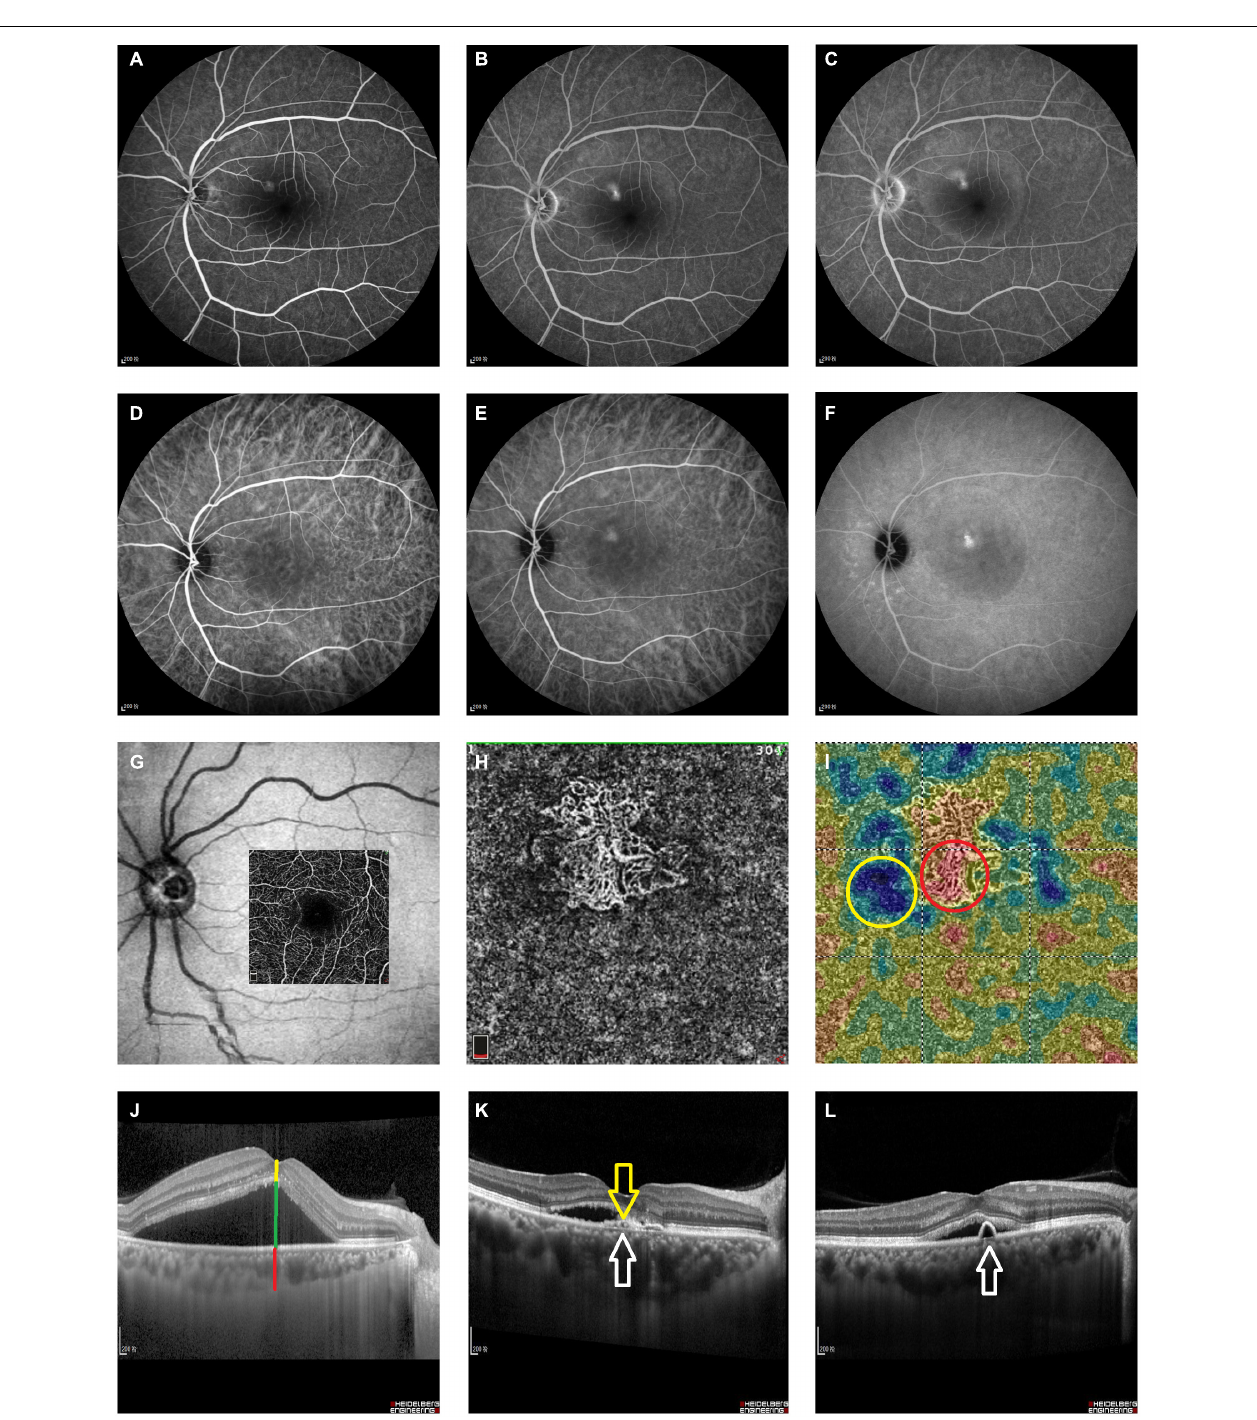
FIGURE 1 | Measurement features extracted from the imaging results. All imaging features used to predict recurrence. Please see Table 1 for detailed descriptions of all measurement features. (A–C) Early, middle and late phase FFA of the left eye of a 52-year-old patient with CSC. (D–F) Contemporaneous ICGA of the same patient. (G) The en face projection slab area of the 3*3 pattern on OCTA. (H) The observation of a superficial choroidal layer on OCTA confirmed the presence of BVN. (I) High- and low-reflection areas in the superficial choroidal layer were surrounded with red and yellow circles, respectively. (J) Horizontal B-scan OCT of a patient with CSC; manual measurements were labeled as follows: yellow line, RNEL; green line, SRF; and red line, ChT; (K) yellow arrow, DLS; white arrow, Bruch membrane; (L) white arrow, PED. VA, visual acuity; FFA, fundus fluorescein angiography; ICGA, indocyanine green angiography; OCT, optical coherence tomography; OCTA, optical coherence tomography angiography; SRF, subretinal fluid; RNEL, retinal neuroepithelial layer; ChT, choroidal thickness; PED, retinal pigment epithelial detachment; DLS, double-layer sign; BVN, branching vascular network.